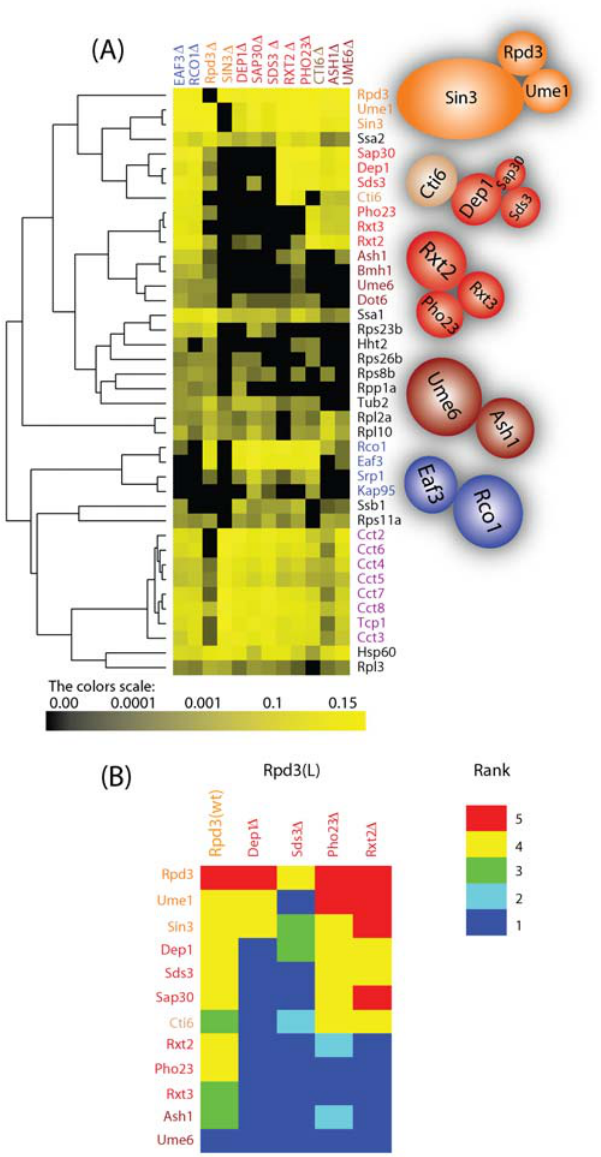
Figure 3. Analysis of Rpd3-TAP Deletion Strains. (A) Hierarchical clustering on the purifications of Rpd3-TAP in different deletion strains. Each column represents an isolated Rpd3-TAP in a different deletion strain, and each row represents an individual protein (prey). The color intensity represents protein abundance (dNSAF) with the brightest yellow indicating highest abundance and decreasing intensity indicat- ing decreasing abundance. Black indicates that the protein was not detected in a particular purification. The proteins of the complexes were colored as in Figure 1. The cluster results in the formation of subcomplexes as illustrated on the right side of the cluster. (B) Ranking of the proteins within the RPD3L complex. Heat map for the protein relative abundance based rank generated from a chromatographic separation of the RPD3 complexes purified through Rpd3-TAP in four deletion strains. Red corresponds to proteins falling in a higher ranked bin (i.e. higher dNSAF) where dark blue corresponds to the lowest ranked bin (i.e. proteins were not identified in the purifications). For visualization purpose we kept only the components of the large